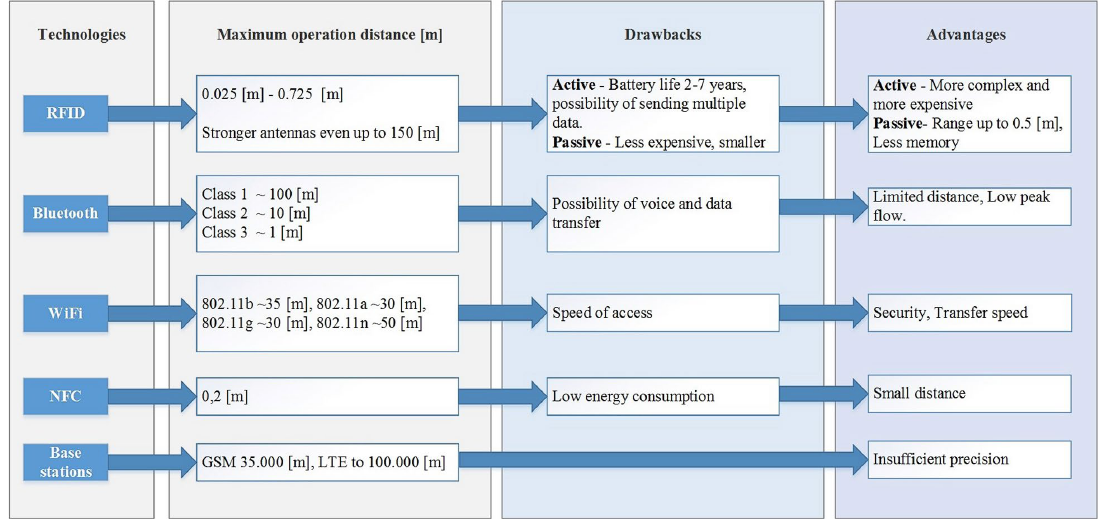
Fig. 1. Characteristics of other technologies in positioning of the user (Peraković et al.